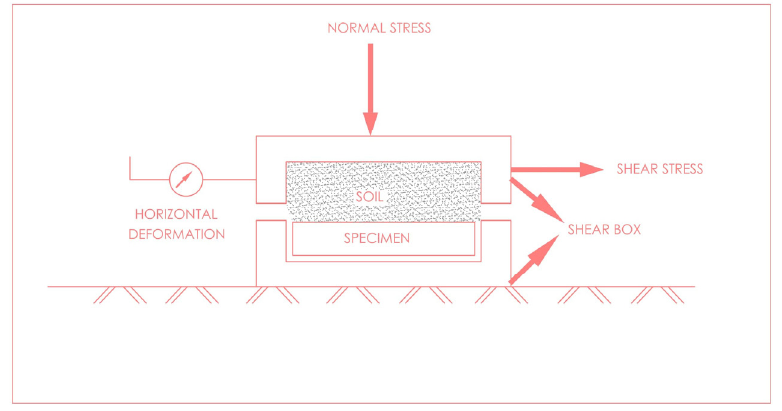
Figure 7. Experimental setup—interfacial friction